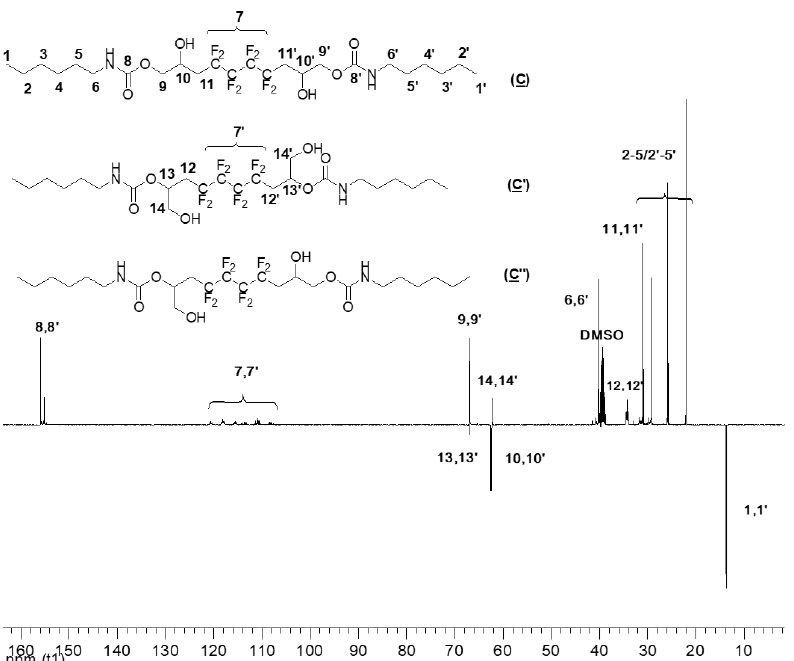
Figure 7. 13 C NMR spectrum of the model hydroxyurethanes ( C ), ( C′ ), and ( C″ ) (DMSO, 20 °C, 100.6 MHz) .